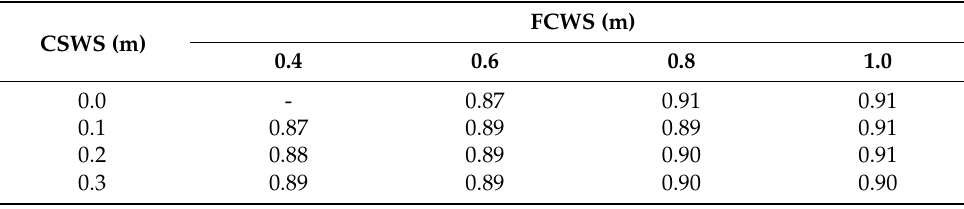
Table 5. The influence of different combinations of CSWS and FCWS on the tree height extraction for C. equisetifolia between UAV-derived image and field measurement ( R 2